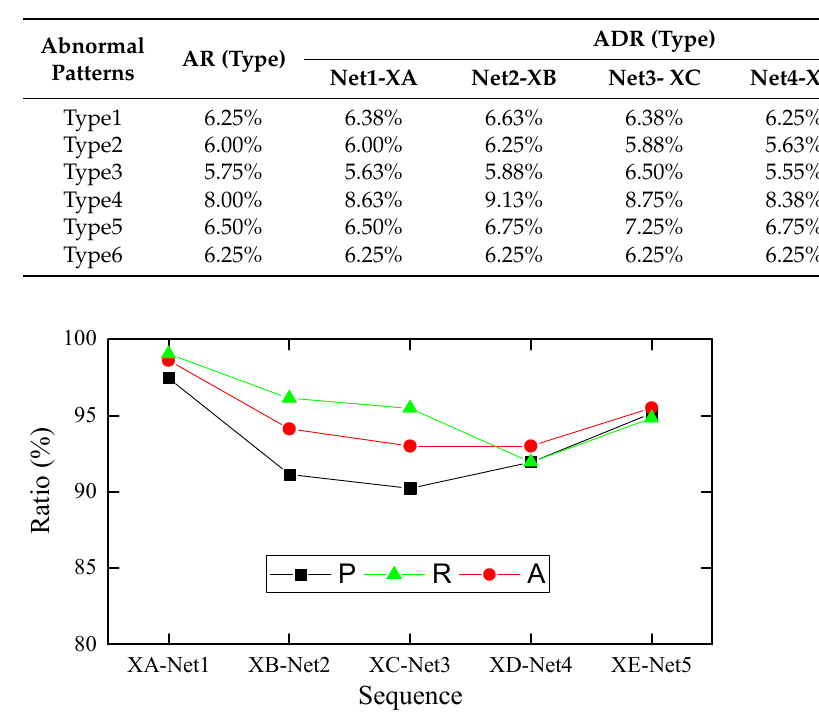
Figure 8. The detection results of numerical example ( ‐ A symbolizes the results with human labeled, ‐ D symbolizes the detected results).